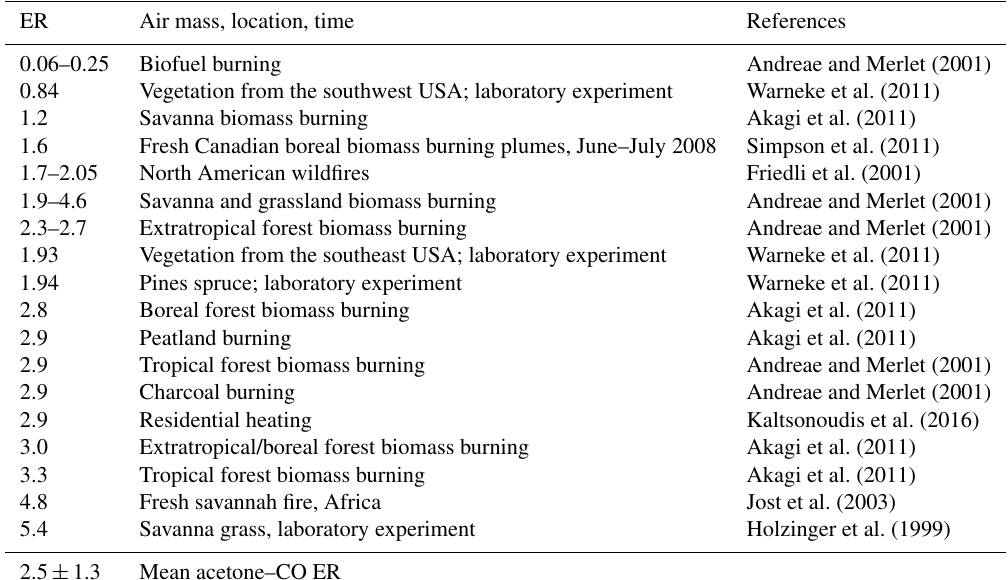
Table 1. Literature values of acetone–CO emission ratios (ERs) in pptppb − 1 .